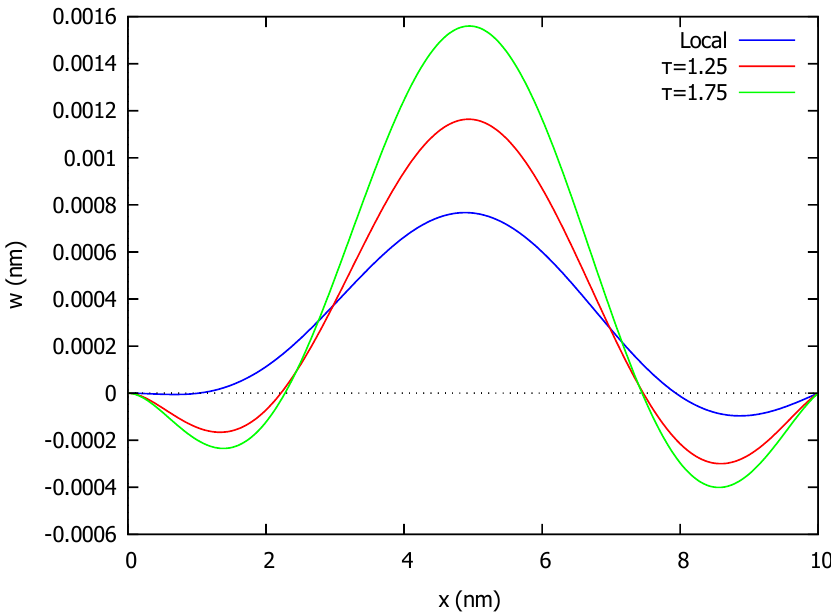
Figure 6. Deflection of clamped pinned beam (CP) under variable load and different values of τ .